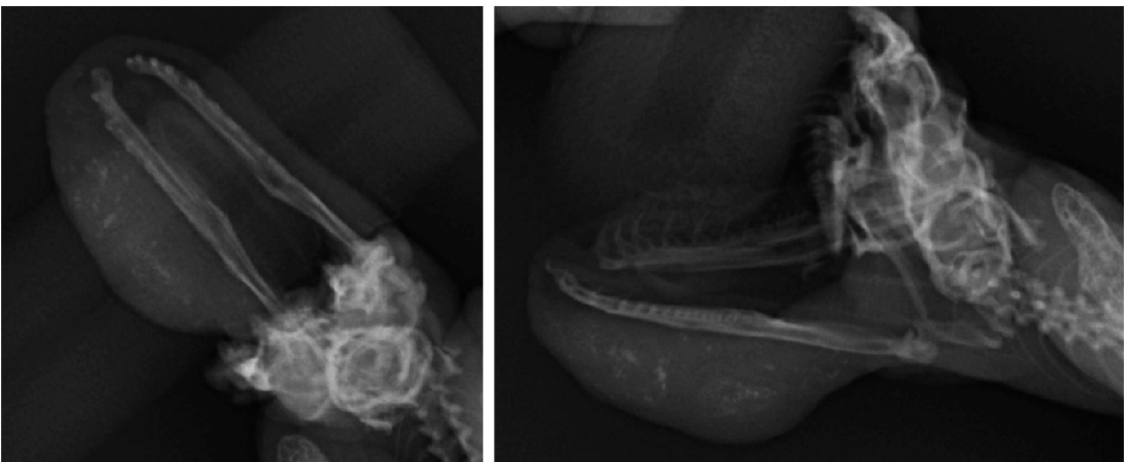
Figure 2. Radiographic examination of the submandibular mass revealed the presence of multi-focal mineralization in the area of the lesion. No evidence of mandibular invasion and lung metastasis was observed.